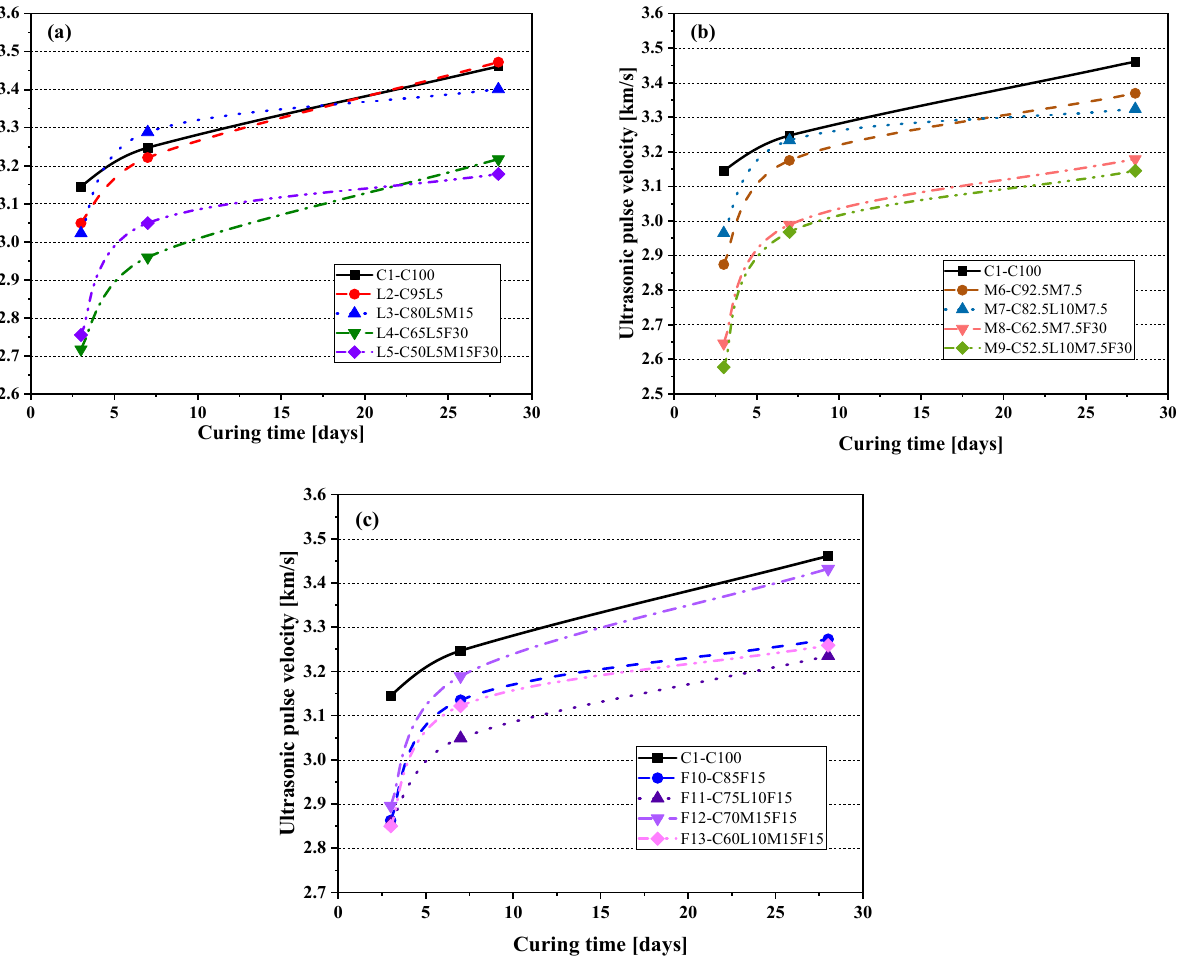
Figure 7. Ultrasonic pulse velocity: ( a ) control specimen and LS system; ( b ) control specimen and MK system; ( c ) control specimen and FA